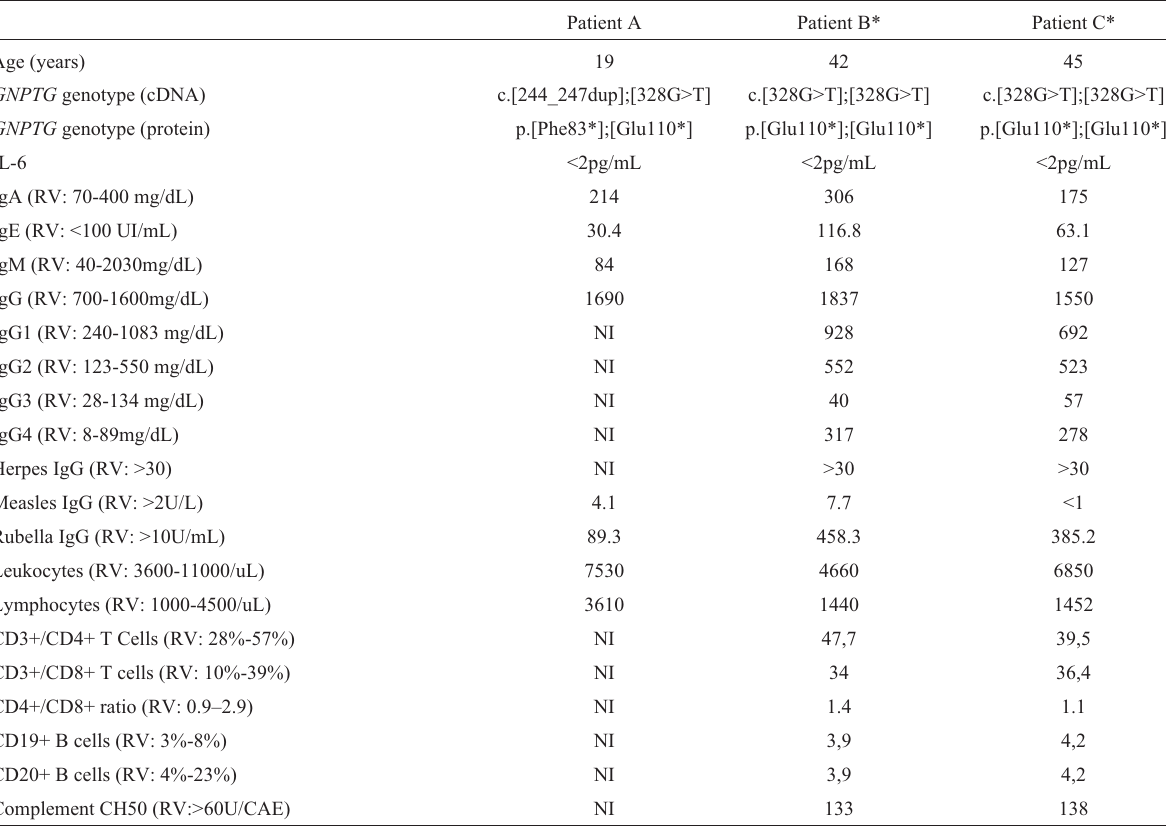
Table 1 - Clinical summary and immunological findings in patients with Mucolipidosis III